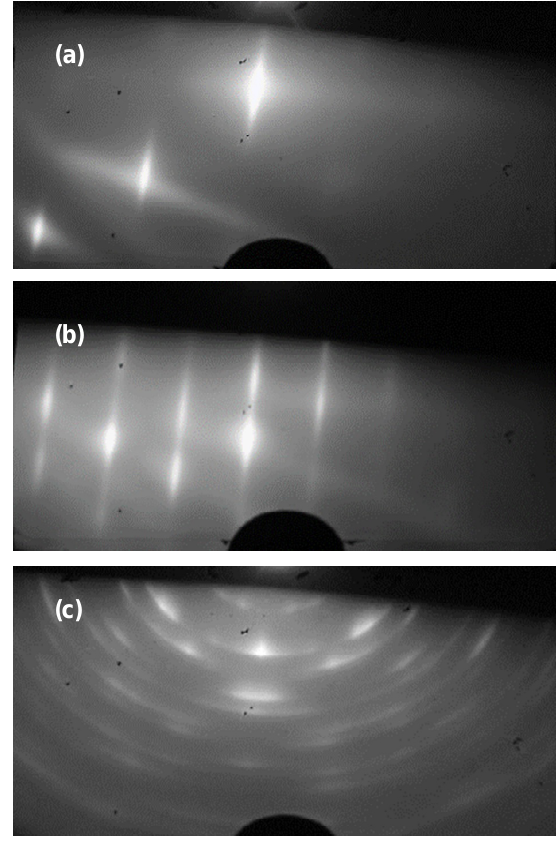
Fig. 1. RHEED patterns of Si samples, grown on Al O ; (a) Si(100)/Al 2 3 Fab-1-R-plane; (b) Si(100)/Al Fab-2-R-plane; (c) Si(111)/Al sapphire